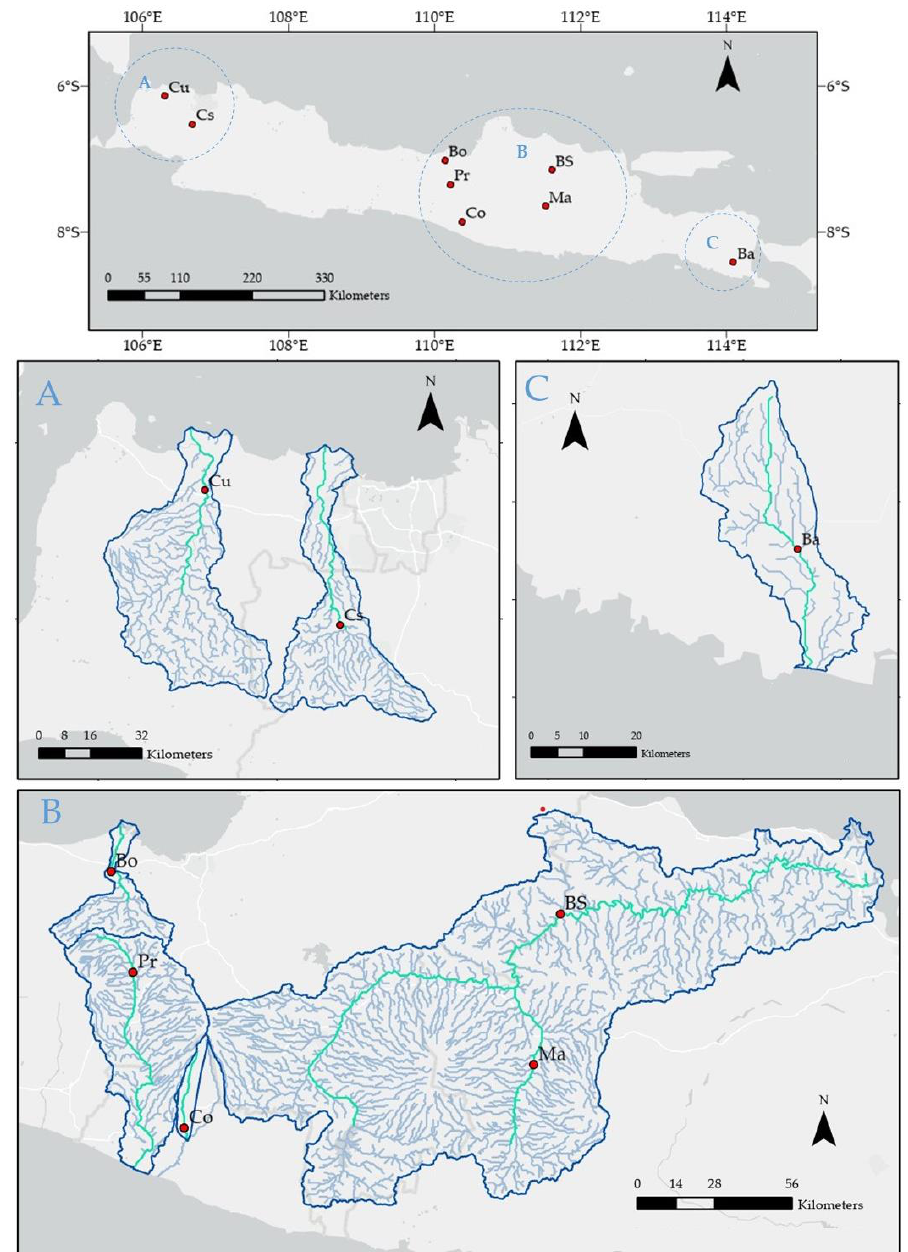
Figure 1. Location of the selected rivers in Java Island, Indonesia.